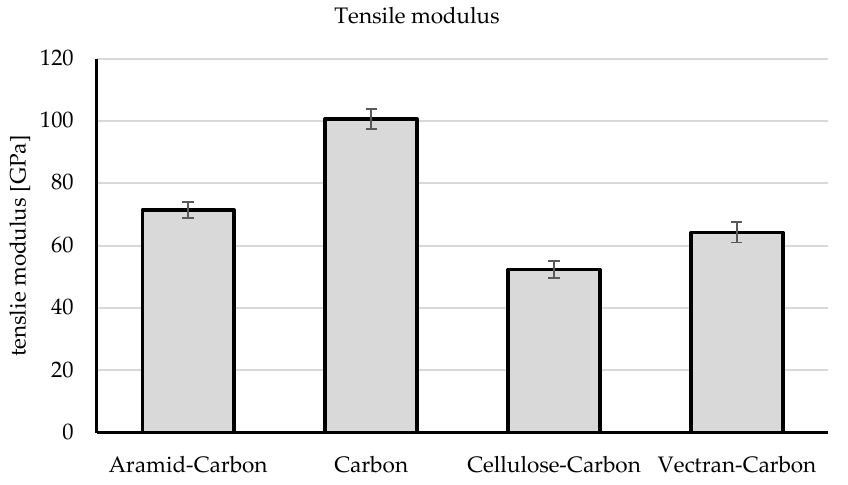
Figure 8. Tensile modulus in fiber direction.